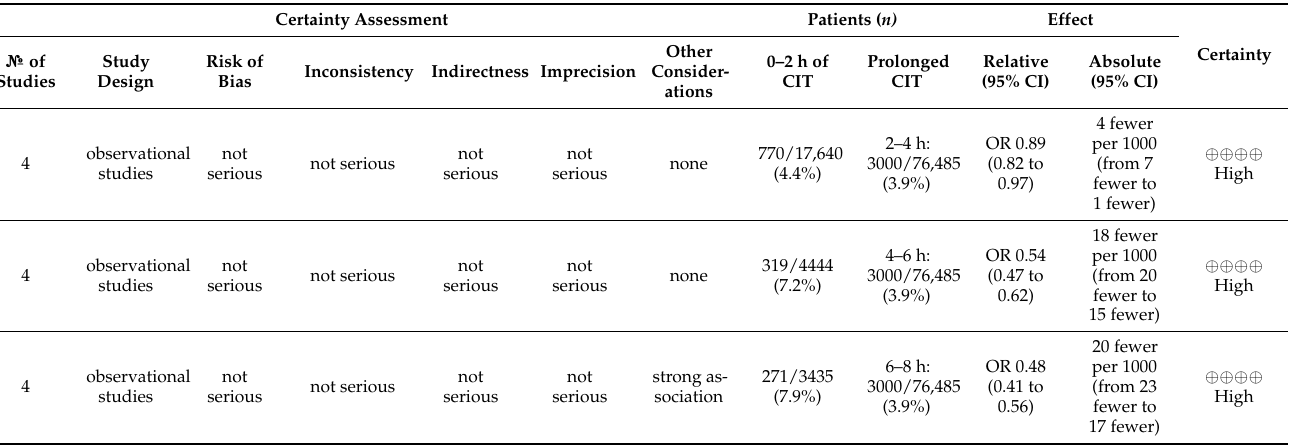
Table A5. Summary of findings with the level of evidence estimated by the Grade-tool for delayed graft function (in further detail).